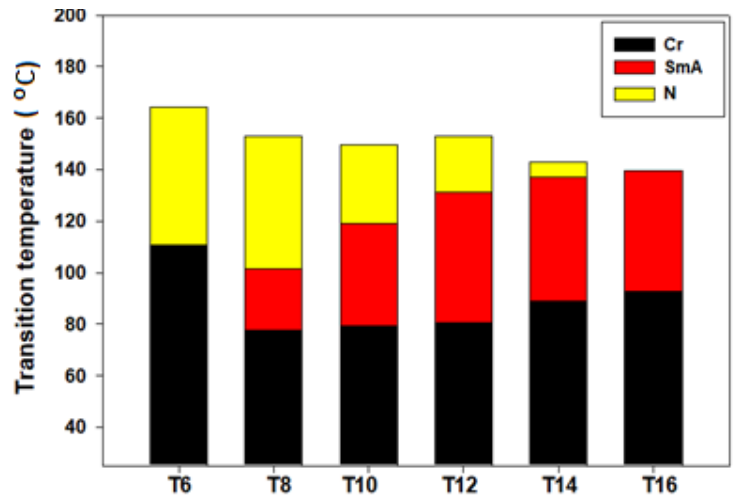
Figure 3. Effect of terminal length on the mesomorphic behavior of Tn series. Table 1. Phase transition temperatures (°C) and (enthalpy of transitions in kJ/mol) of Tn . Compounds T Cr-SmA